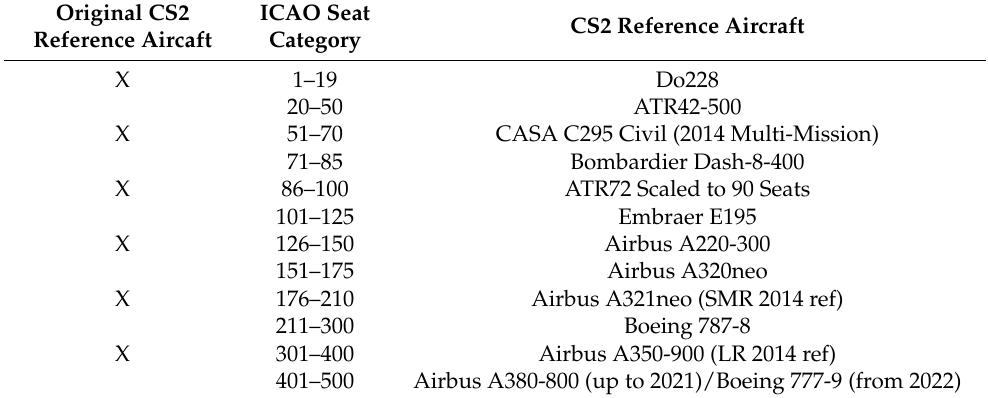
Table 3. Reference aircraft.